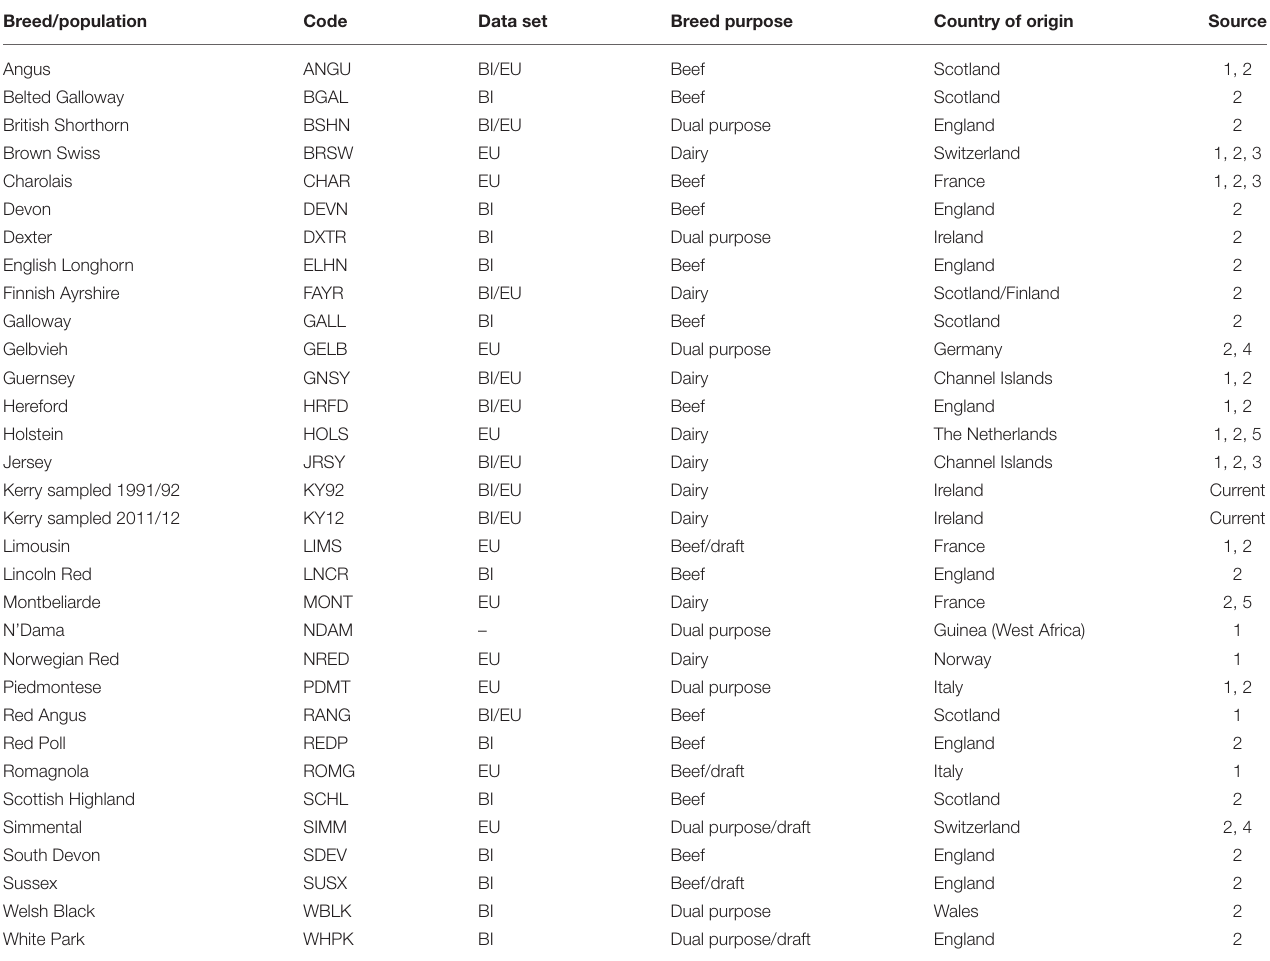
TABLE 1 | Cattle breed/population samples used for the present study.